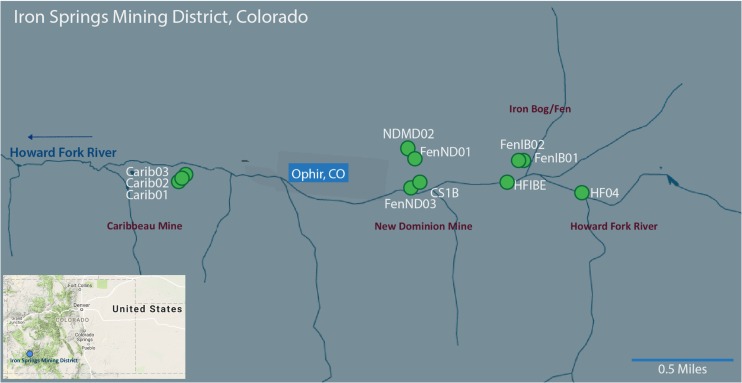
Map of the study sites within the Iron Springs Mining District near Ophir, Colorado. Individual sample sites are denoted with a green circle. Sampling regions are denoted in purple. Arrow indicates the direction of flow for the Howard Fork River. Base images modified from Google Maps (Map data Google 2015 and © Google 2017).